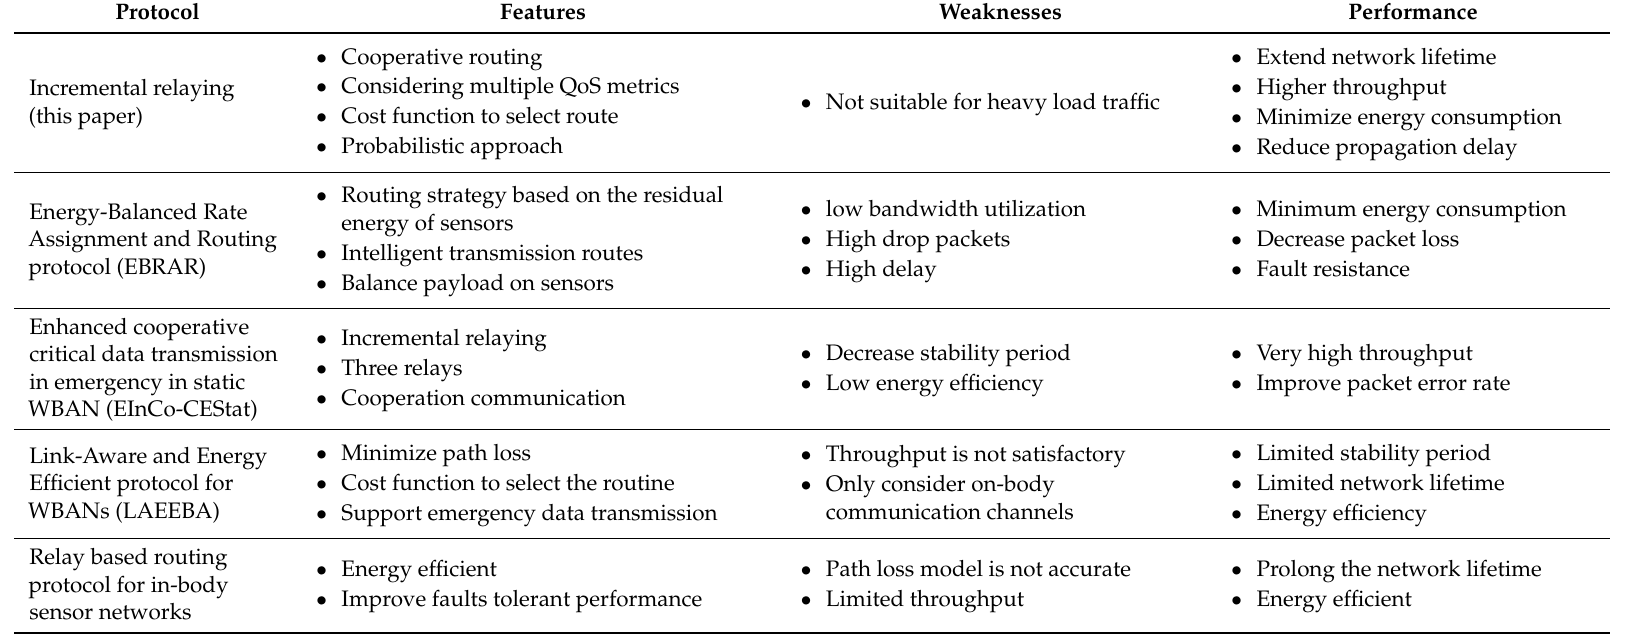
Table 8. Comparison of the Proposed Protocol With Other State of Art Techniques